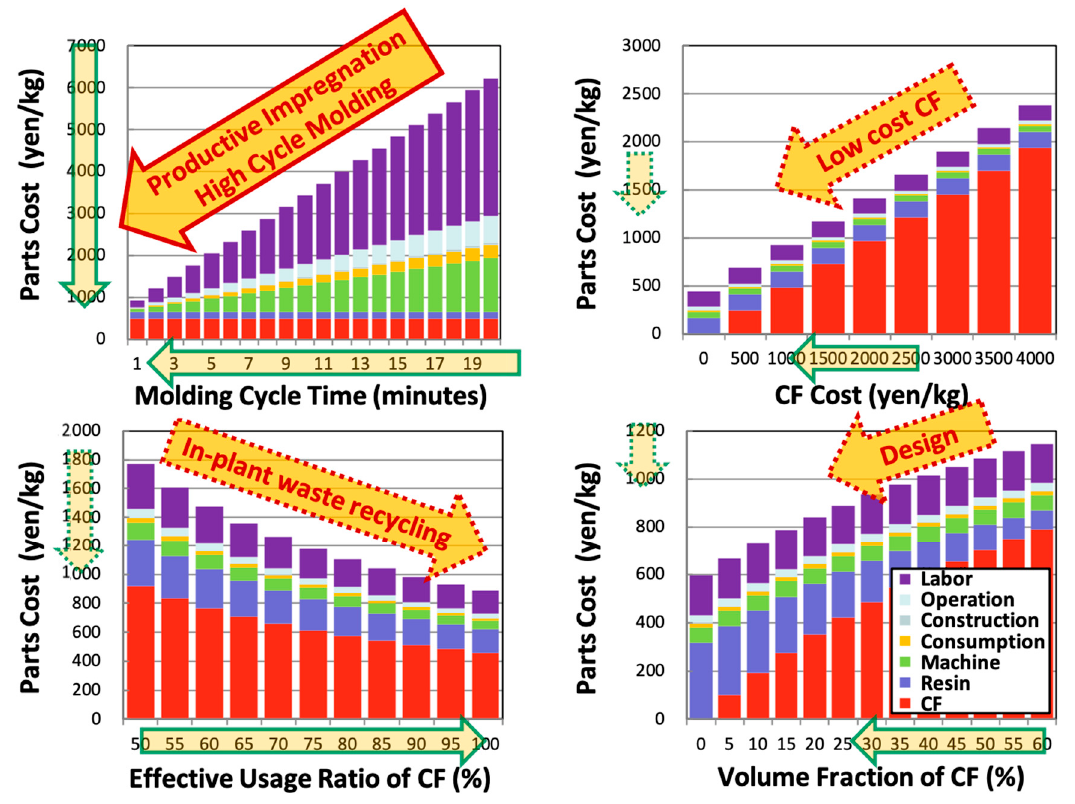
Figure 4. Sensitivity analysis of the different factors on the cost of CFRP automotive parts.